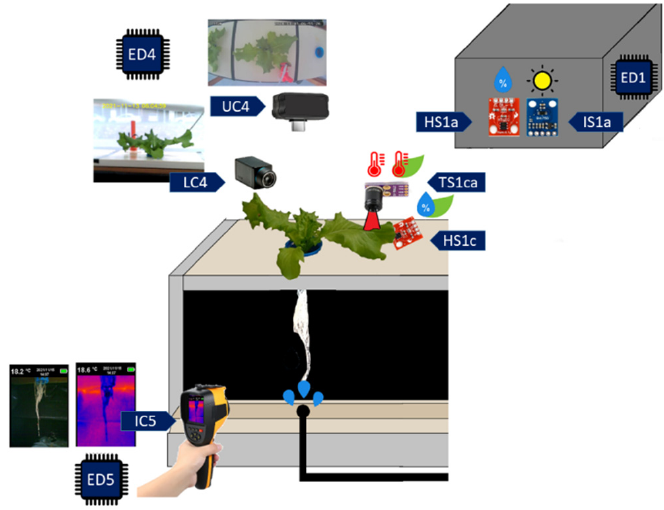
Figure 2. Location of sensors and visual inspection system.